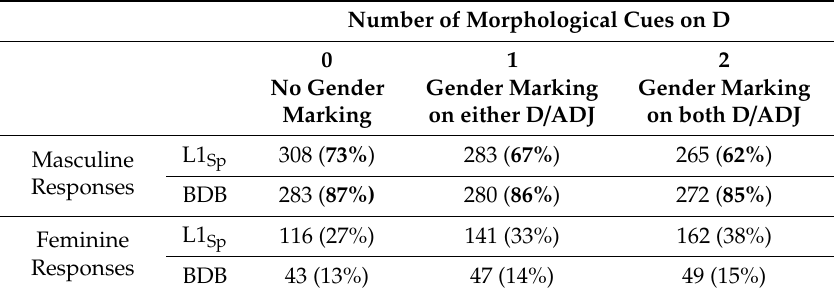
Table 6. Distribution of participants’ responses, by contextual